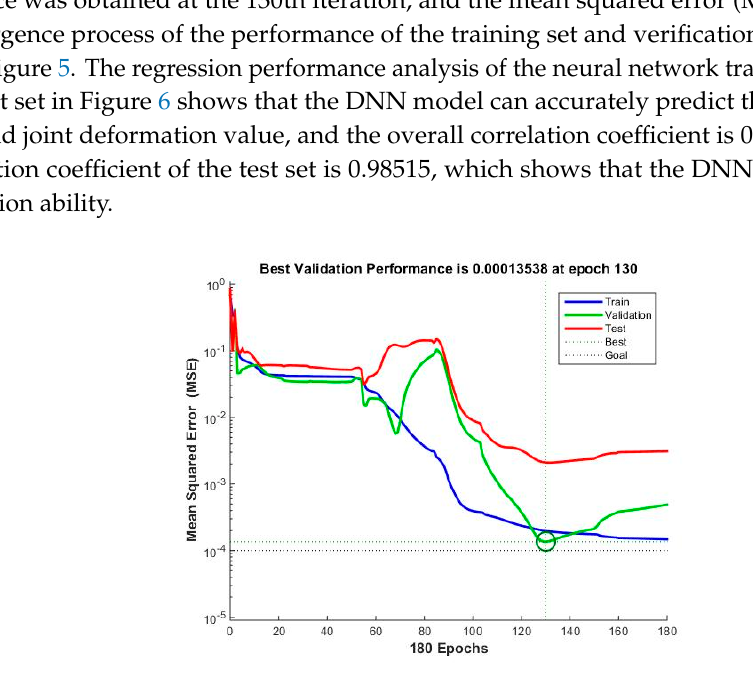
Figure 6. The regression performance analysis of the DNN model. 3.3. Double-Factors Analysis Based on Prediction Data of DNN Model From orthogonal analysis, it can be seen that the influence weight of the bonding temperature and bonding pressure is close. Obviously, the bonding temperature and bonding pressure have a coupling effect on the bonding performance and deformation, which makes it difficult to judge their influence by single-factor analysis. Meanwhile, the influence weight of duration is significantly lower than that of the bonding temperature and bonding pressure. Additionally, the duration are often set with the heat treatment cycle of base metal to ensure its welded strength [2]. Therefore, duration was taken as a constant in this study, and the double-factors influence of temperature and pressure on welding performance was given priority. The trained DNN model can predict the tensile strength and deformation ratio of bonding joints in the temperature range of 1050–1150 °C and the pressure range of 20–50 MPa. The input matrix was composed by uniformly selecting temperature values and pressure values within this range, and the duration was constant for 30, 60, and 90 min. Three sets of input matrices were fed into the DNN model, and the prediction results were plotted as a contour map, as shown in Figures 7 and 8.